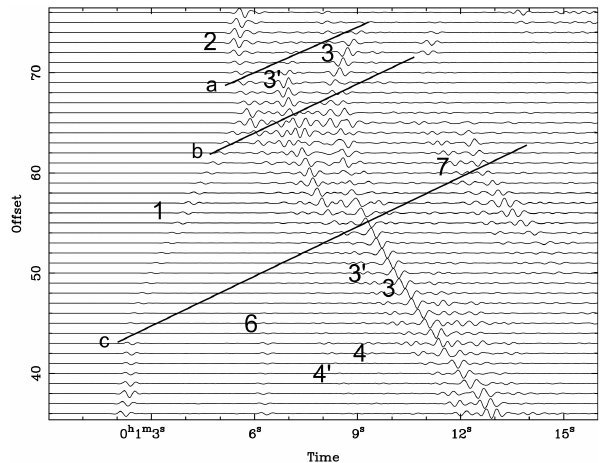
Fig.9: Model without DSC:time-reducedrecordsectionofsynthetichorizontalcomponentseismogramscomputedatreceiversatthesur- face.Numbersfrom1to8markmajorseismicphases.(1)P-waverefractedattheinterfacebetweensubductedoceaniccrustandlithospheric Fig. 9: Model without DSC: time-reduced record section of mantle,(2)directP-phase,(3)firstguidedP-phaseemergingfromthedeepoceaniccrust,(4)secondguidedP-phaseemergingfromthedeep oceaniccrust,(5)thirdguidedP-phasedevelopingintheserpentinizedmantlewedge,(6)refractedS-phaseconvertedfromdirectP-phaseat synthetic horizontal component seismograms computed at interfacebetweensubductedoceaniccrustandlithosphericmantle,(7)S-conversionofupgoingguidedphase5atserpentinizedwedge-crust interface,(8)surfacereflectionofdirectPphasereflectedbackatslabinterface.Solidlinescrossingseismogramsindicatelinesofconstant receivers at the surface. Numbers from 1 to 8 mark major timeforcomparisonwithsnapshotsa-cofFig.8ontheright.Associatedtimesfromtoptobottomare: t = 24.2s,27.5sand36.3s. Source isexplosiveandat108kmdepth. seismic phases. (1) P wave refracted at the interface between subducted oceanic crust and lithospheric mantle, (2) direct P phase, (3) first guided P phase emerging from the deep oceanic crust, (4) second guided P phase emerging from the deep oceanic crust, (5) third guided P phase developing in the serpentinized mantle wedge, (6) refracted S phase con- verted from direct P phase at interface between subducted oceanic crust and lithospheric mantle, (7) S conversion of up- going guided phase 5 at serpentinized wedge–crust interface, (8) surface reflection of direct P phase reflected back at slab interface. Solid lines crossing seismograms indicate lines of constant time for comparison with snapshots a–c of Fig. 8 on the right. Associated times from top to bottom are t = 24 . 2 s, 27.5 s and 36.3 s. Source is explosive and at 108 km depth.